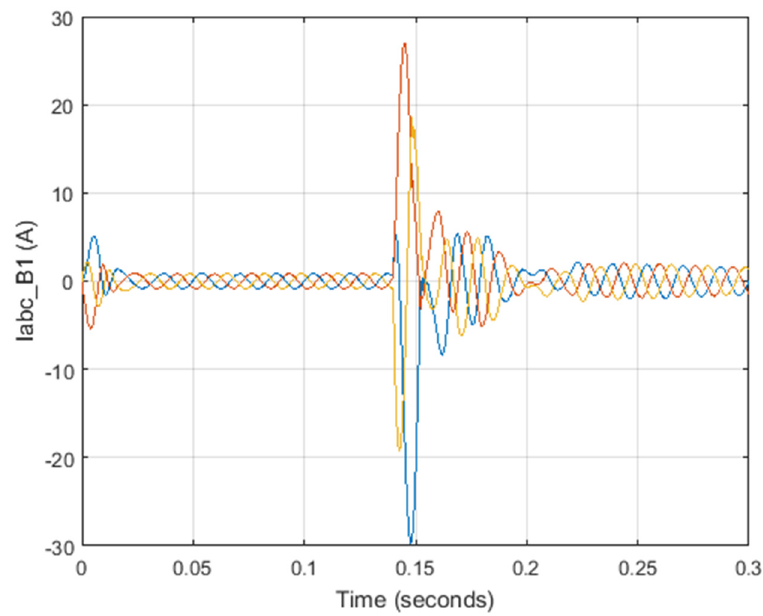
Figure 14. Common point (common base) grid and microgrid current.